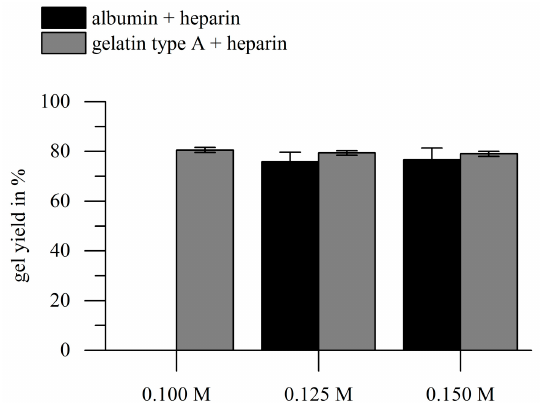
Figure 2. Results of the gravimetric determination of the gel yield of hydrogels. Hydrogels were